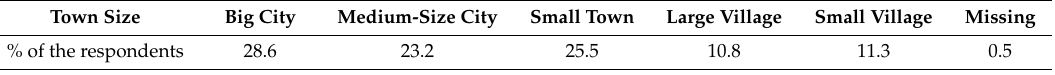
Table 5. The distribution of the respondents in different sizes of settlements (%).